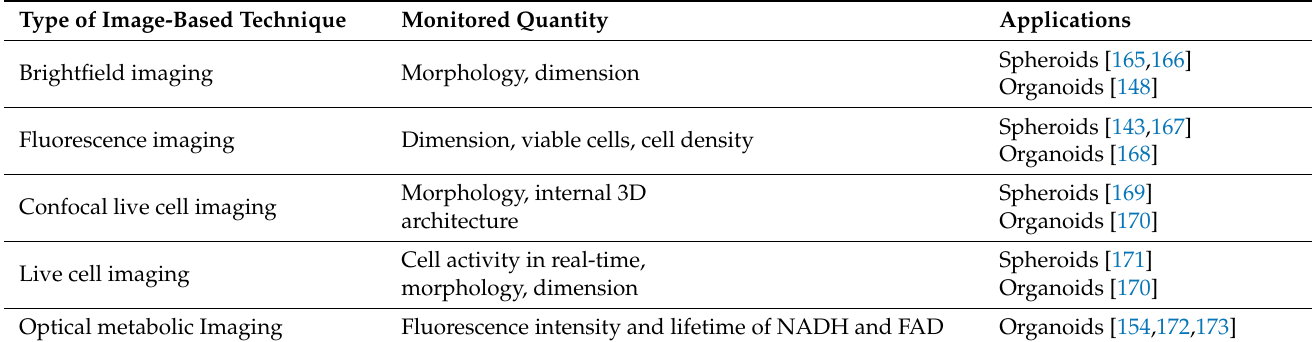
Table 5. Image-based assays commonly applied in spheroid and organoid